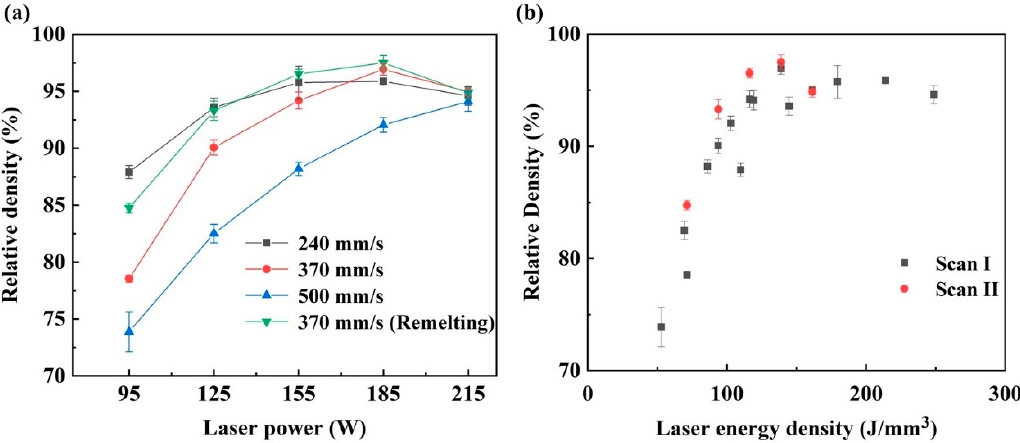
Figure 10. The relative densities of the cemented carbide parts: ( a ) The relative density at different process parameters; ( b ) the relative density at different laser energy densities.